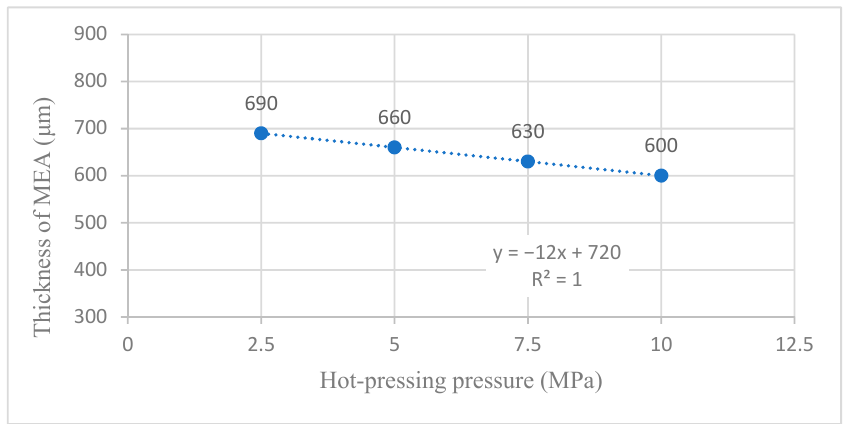
Figure 18. The fitting curve of the thickness of MEA at different hot-pressing pressure without 0 MPa sample.